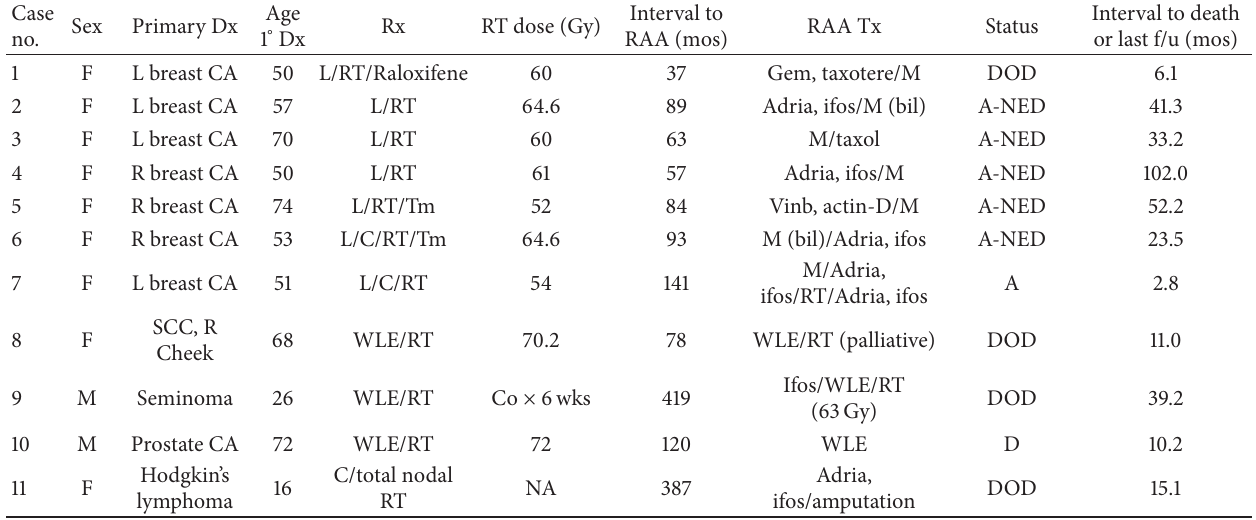
Table 1: Summary of clinical features in radiation-associated angiosarcoma (RAA) patients.